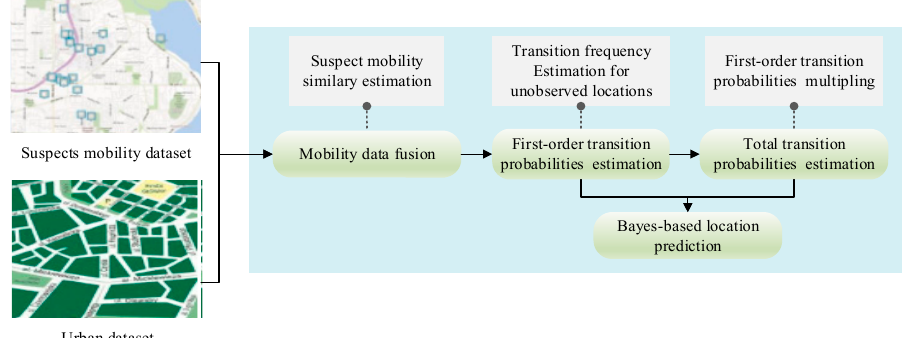
Figure 1. Overall workflow of location prediction.